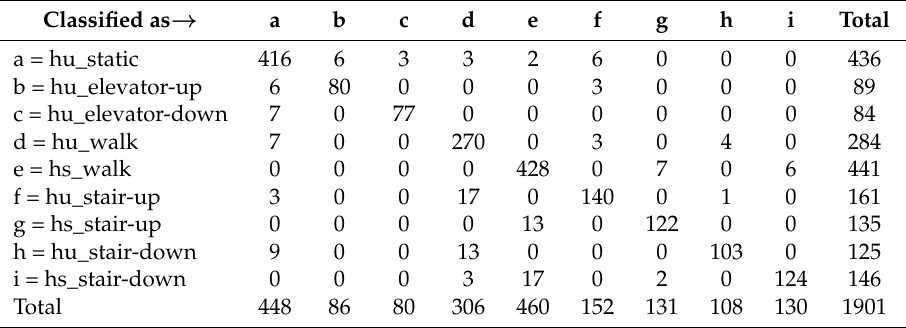
Table 9. Confusion matrix of multi-floor motion recognition using original RF with PCR2&5. Classified as